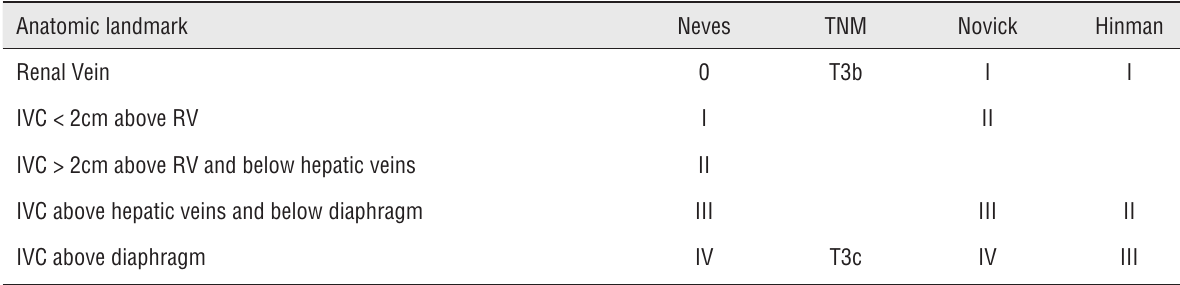
Table 2 - Different staging systems of IVC tumor thrombus in literature. Anatomic landmark